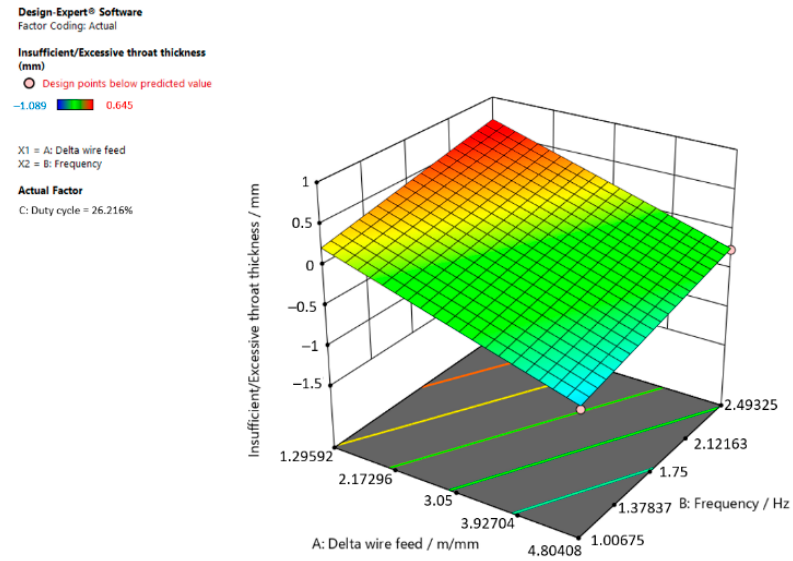
Figure 3. Response surface for the regression model of insufficient/excessive throat thickness at a duty cycle of 26.216%.